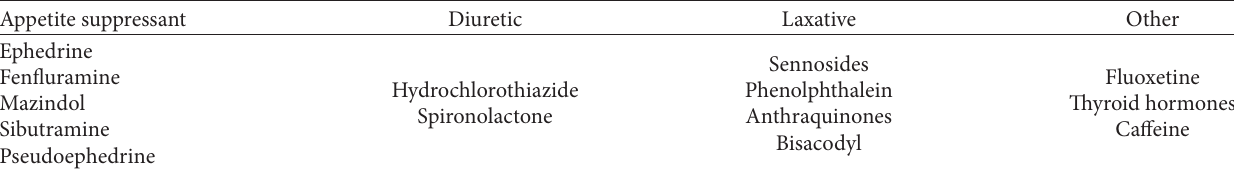
Table 1: Common drugs hidden in weight loss pills [1, 7].